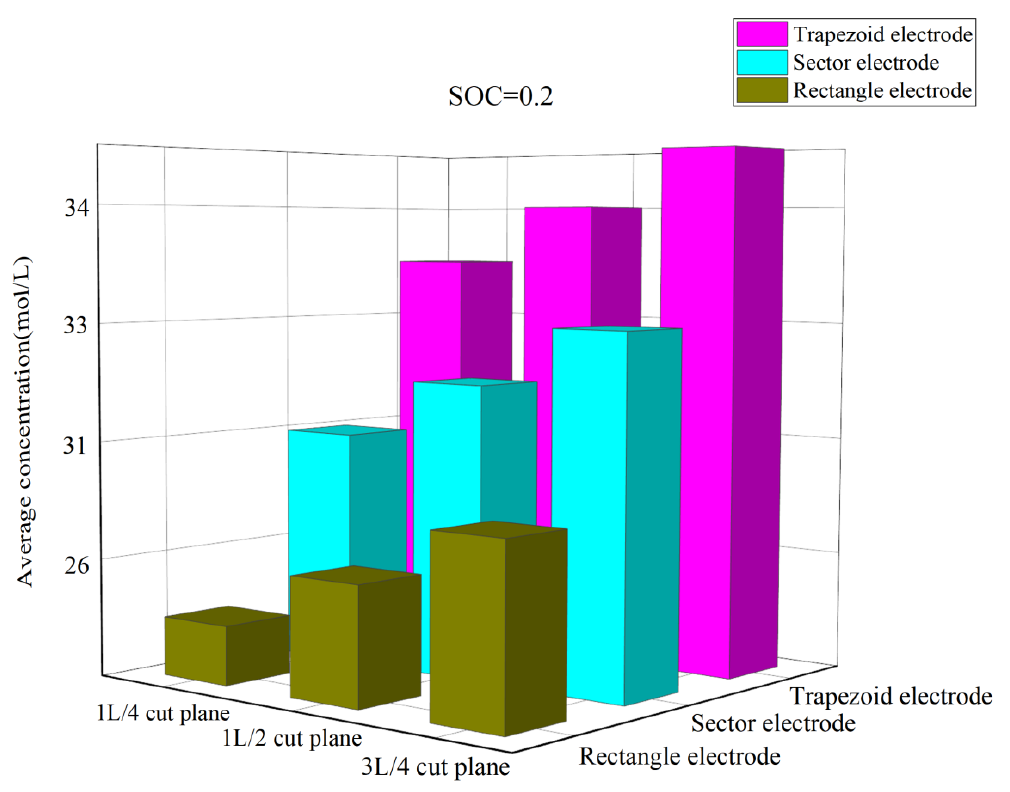
Figure 10. Average concentration of different batteries at different slice positions and at 0.2 SOC.